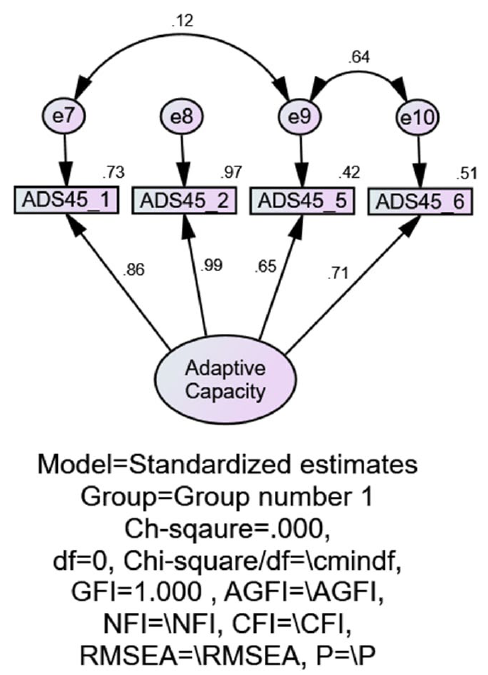
Figure A2. First-order factor model.